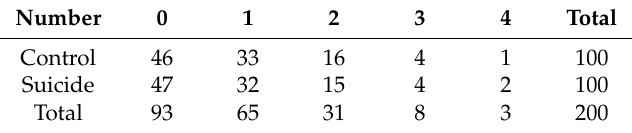
Table 1. Number of additional diagnoses apart from MDD-M/P.